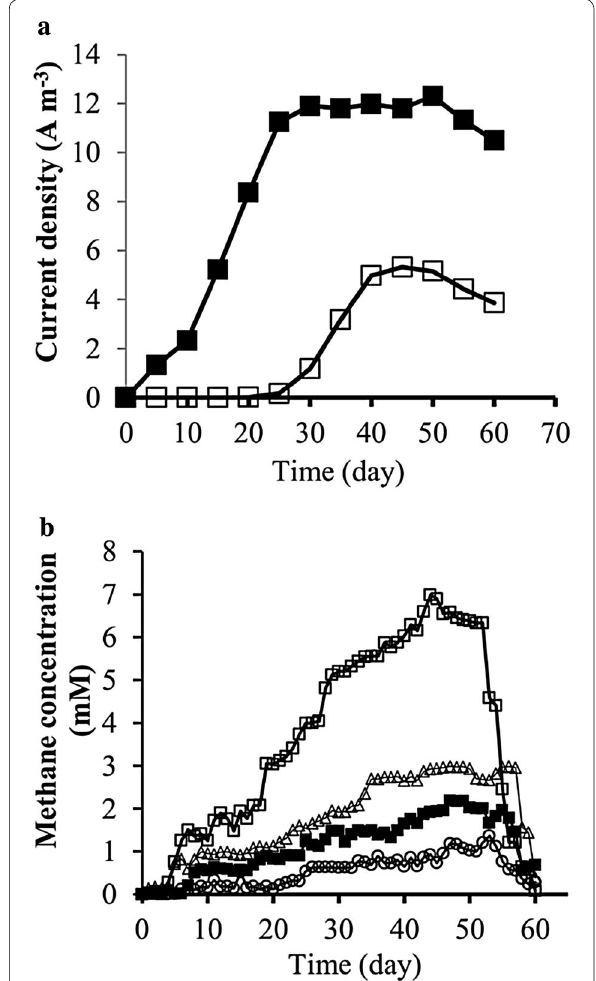
Fig. 2 Effect of dilution of raw wastewater on current density and CH 4 gas evolutions. a Current density evolution in MFC 2. Electrodes: (black square) RHCE, (white square) CCE; b methane gas production in MFCs. CCE; (white square) MFC 1, (Greek capital letter delta) MFC 2. RHCE; (black square) MFC 1, (white circle) MFC 2. The peak volumet- ric current density observed for RHCE-MFC 2 was 12.3 A m − 3 while the peak current density for CCE-MFC 2 was 5.3 A m − 3 ( a ). The peak methane gas concentration for CCE-MFC 2 was 2.9 mM while that of RHCE-MFC 2 was 1.2 mM ( b )